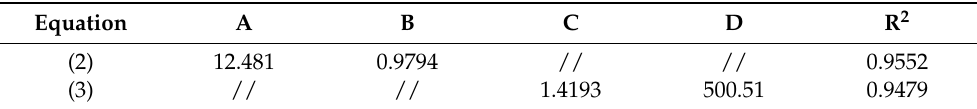
Table 3. Values of the coefficients of the experimental equations describing the trends of T cell and P el,cell